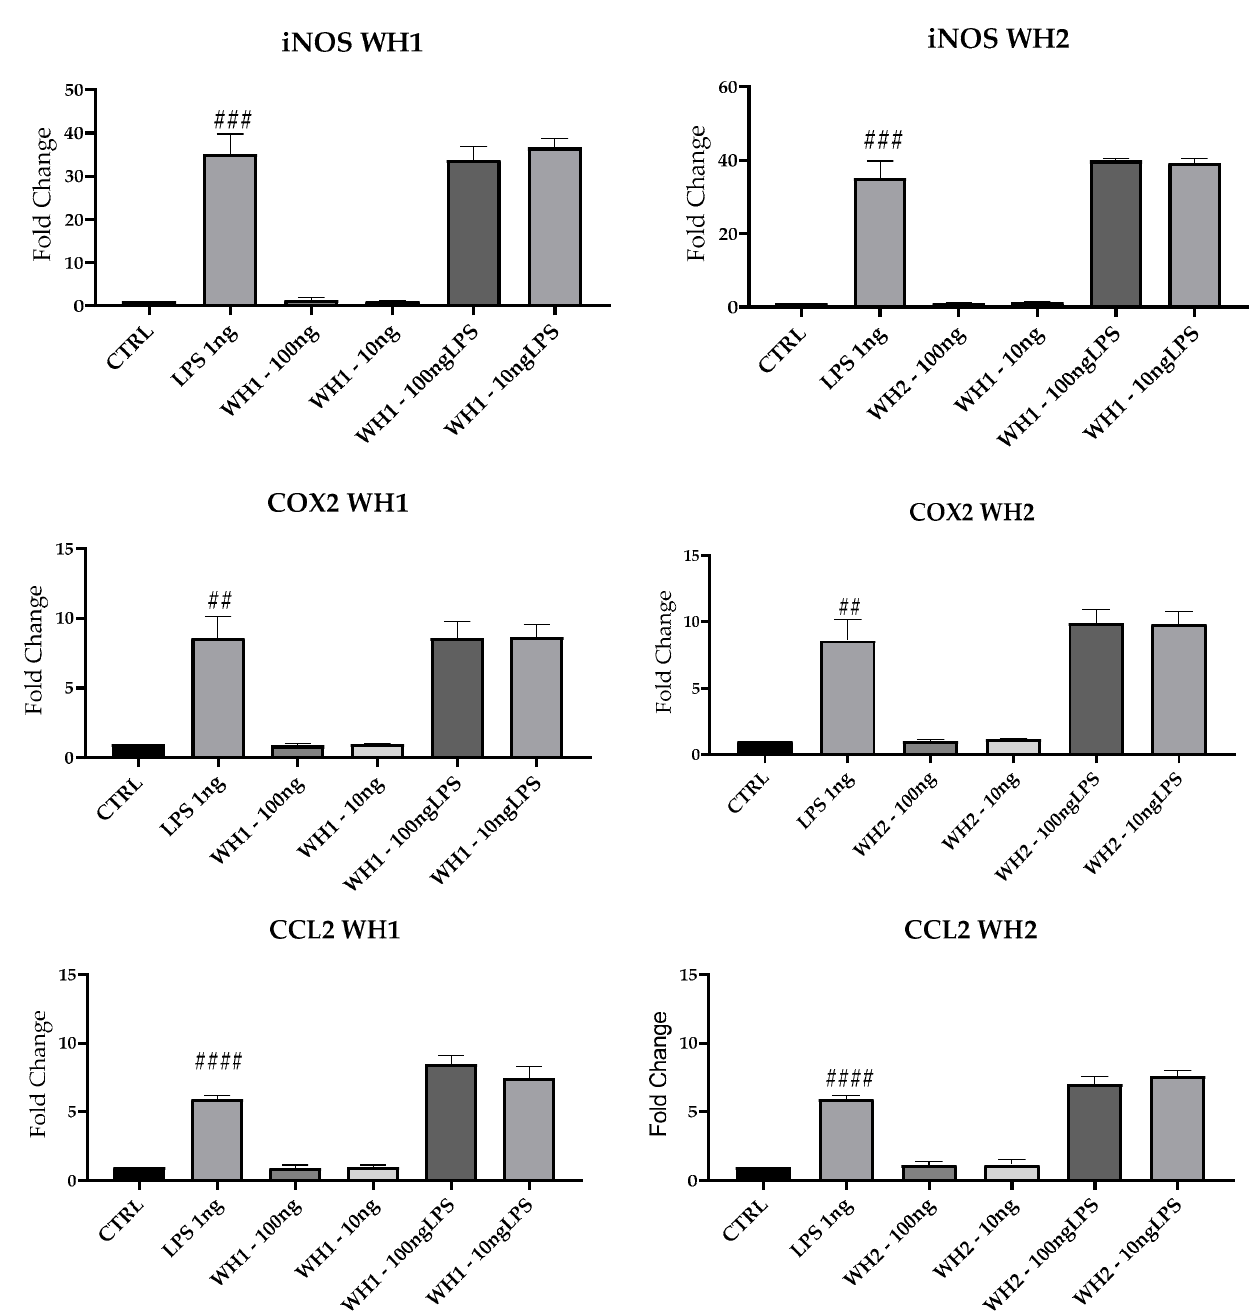
Figure 5. mRNA expression of iNOS, COX2, and CCL2 was evaluated by qRT-PCR. Data are shown as mean ± SD from three independent experiments performed in triplicate. Expression profiles were determined using the 2 − ∆∆ CT method. # VS CTRL; ## p < 0.01; ### p < 0.001; #### p < 0.0001. Expression of ARG-1 mRNA was induced by the addition of extracts obtained from WH1 and WH2 husk at both 100 and 10 ng/mL concentrations and compared with CTRL. Pretreatment with 10 ng/mL of WH2 husk extracts significantly increased ARG-1 mRNA expression also after the addition of LPS. The mRNA expression of CD206 increased significantly compared with CTRL after addition of WH1 100 and 10 ng/mL and WH2 10 ng/mL. In both chains, ARG-1 expression increased in cells pretreated with the extracts obtained from Pula in the presence of